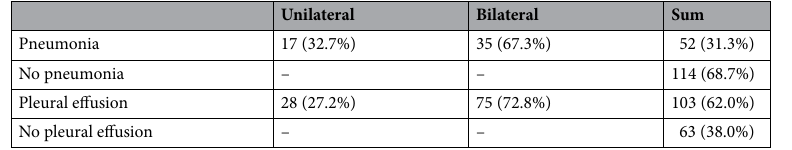
Table 2. Characteristics of the SCXR BLO cohort. The table shows the absolute and relative quantities of the subgroups that are covered in the cohort. The pneumothorax group is furthermore subdivided in terms of the measured maximal pleural